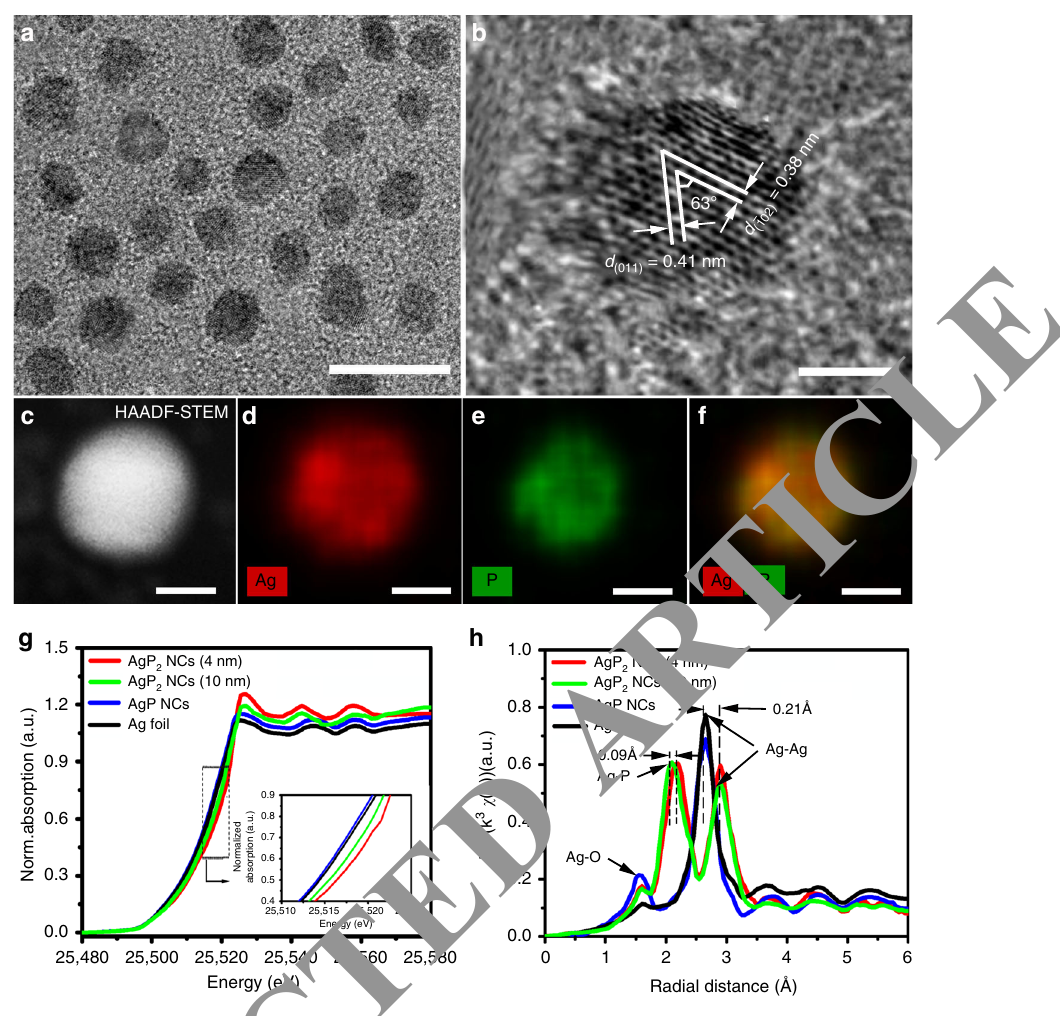
Fig. 1 Materials characterization of AgP 2 NCs. a TEM image, scale bar 10 nm. b HRTEM image, c HAADF-STEM, d – f elemental mapping images of AgP 2 NCs. Scale bars 2 nm. g X-ray absorption near-edge structure (XANES) spectra of 4 nm AgP 2 NCs, 10 nm AgP 2 NCs, 10 nm Ag NCs, and Ag foil. h Corresponding extended X-ray absorption fi ne structure (EXAFS)